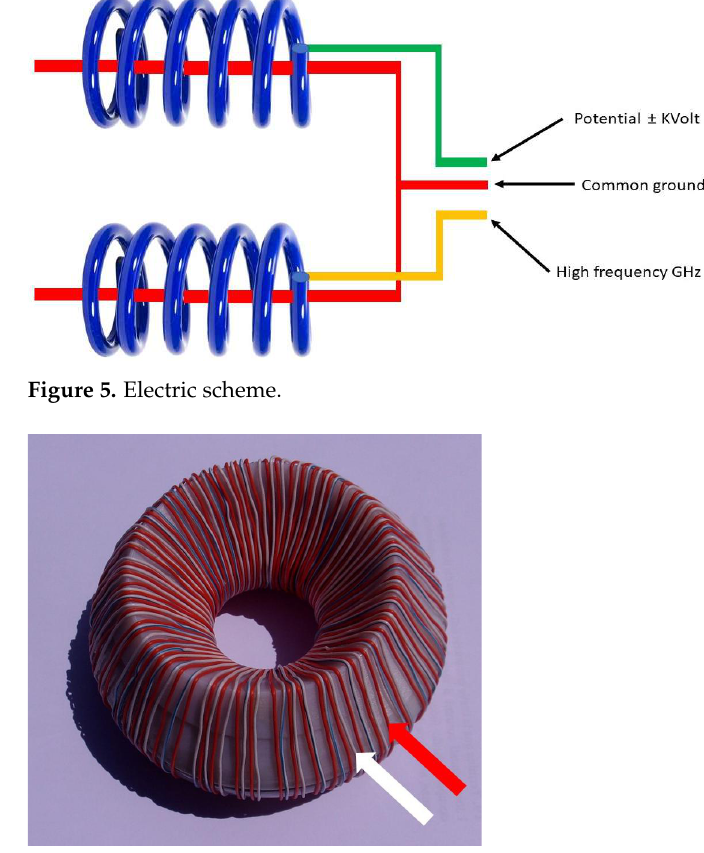
Figure 6. Final appearance of the ring. There are two independent coils. The one indicated by the red arrow is supplied with an alternate radio-frequency signal. The one indicated by the white arrow is connected to the high-voltage generator. The common ground is represented by the copper wire running inside the ring as shown in Figure 4a. The corresponding electric diagram is visible in Figure